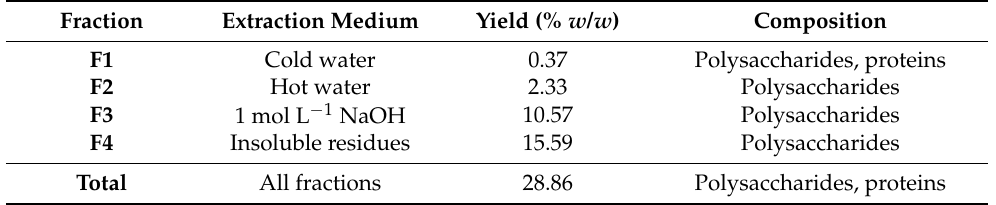
Table 1. Yields and composition of the fractions obtained.